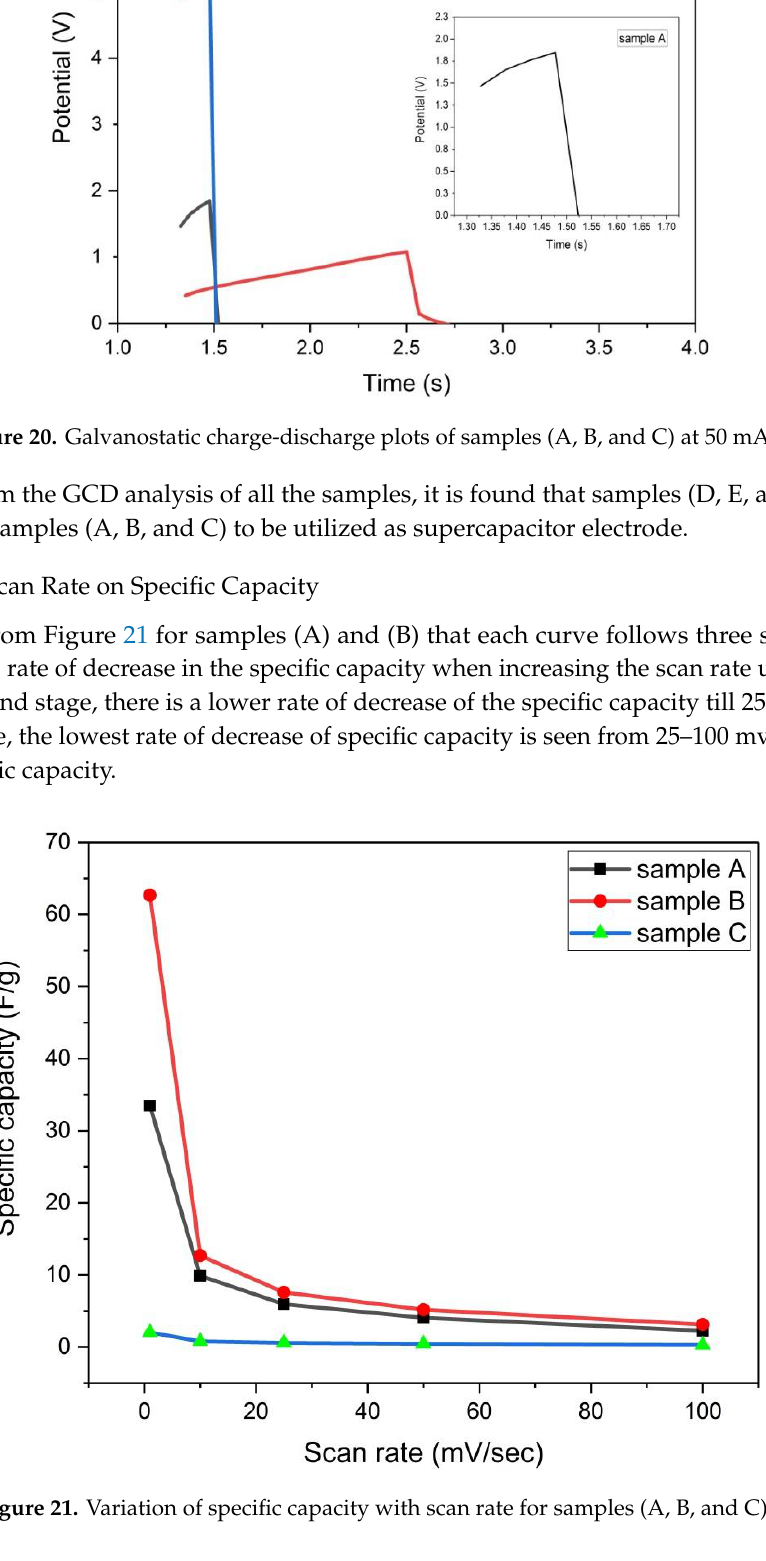
Figure 20. Galvanostatic charge-discharge plots of samples (A, B, and C) at 50 mA/g.